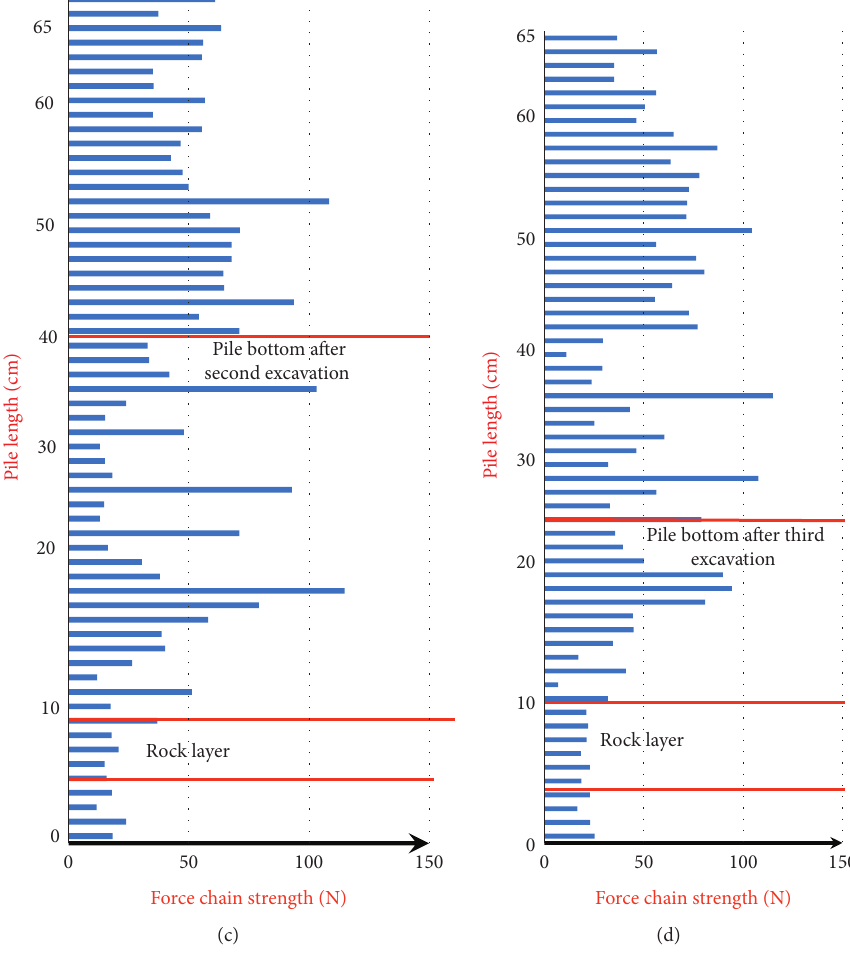
Figure 12: Size of force chains behind